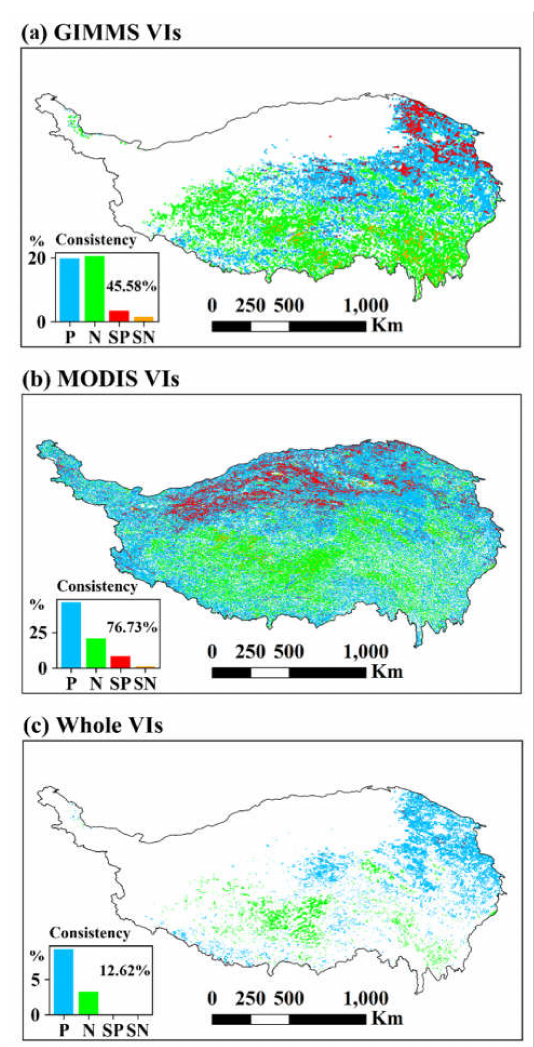
Figure A1. Consistency of the spatial pattern of the VI variations from 2001 to 2016: ( a ) represents the consistency of GIMMS Vis, ( b ) represents the consistency of MODIS Vis, and ( c ) represents the consistency of all VIs. The percentages of the area of positive (P), negative (N), significantly positive (SP), and significantly negative (SN) consistency are shown in the lower-left